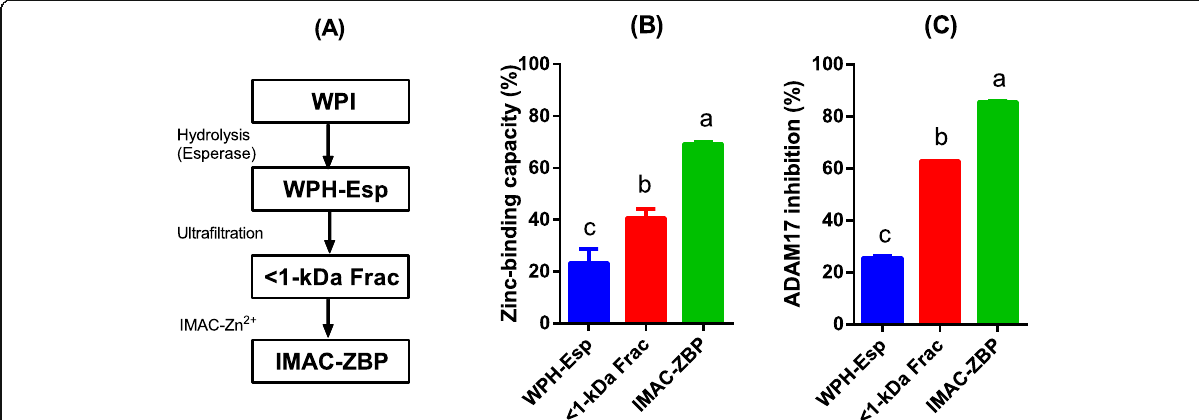
Fig. 3 ( a ) Process for the production of the zinc-binding peptides (IMAC-ZBP) from whey proteins (WPI). ( b ) Zinc-binding capacity and ( c ) ADAM17 inhibitory activity of WPH-Esp, its <1kDa fraction and IMAC-ZBP. Bars with different letters are significantly different mean values (P<0.05). WPH-Esp, whey protein hydrolysate produced with